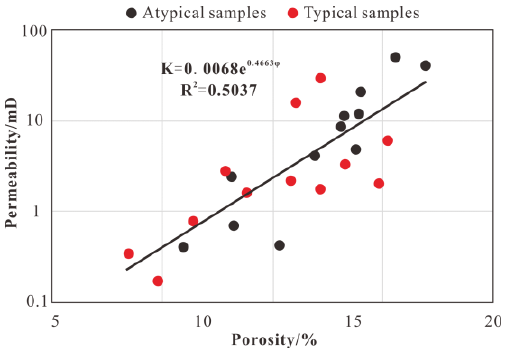
Figure 4. Correlation between porosity and permeability of samples from 24 coring wells.